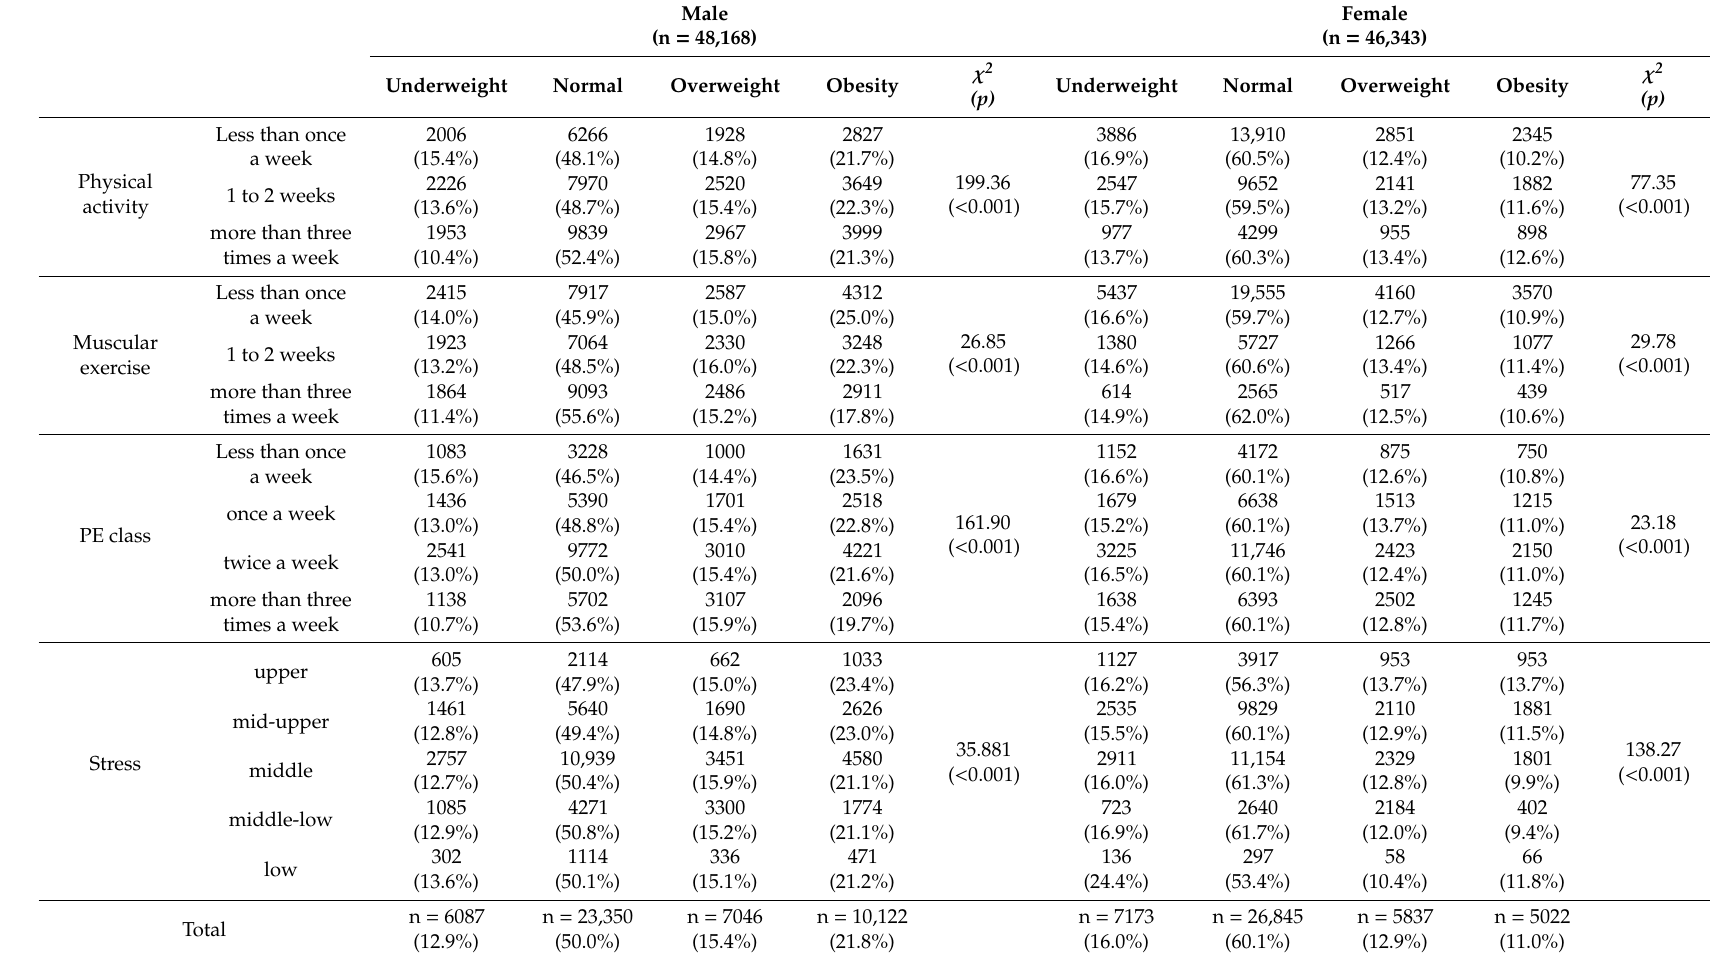
Table 4. Relationship between Physical Activity and Obesity in